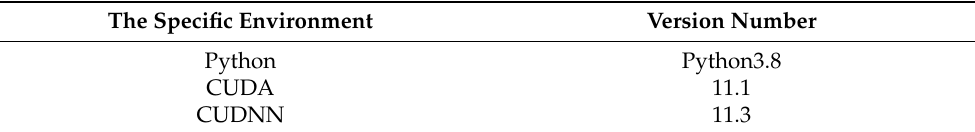
Table 4. Software